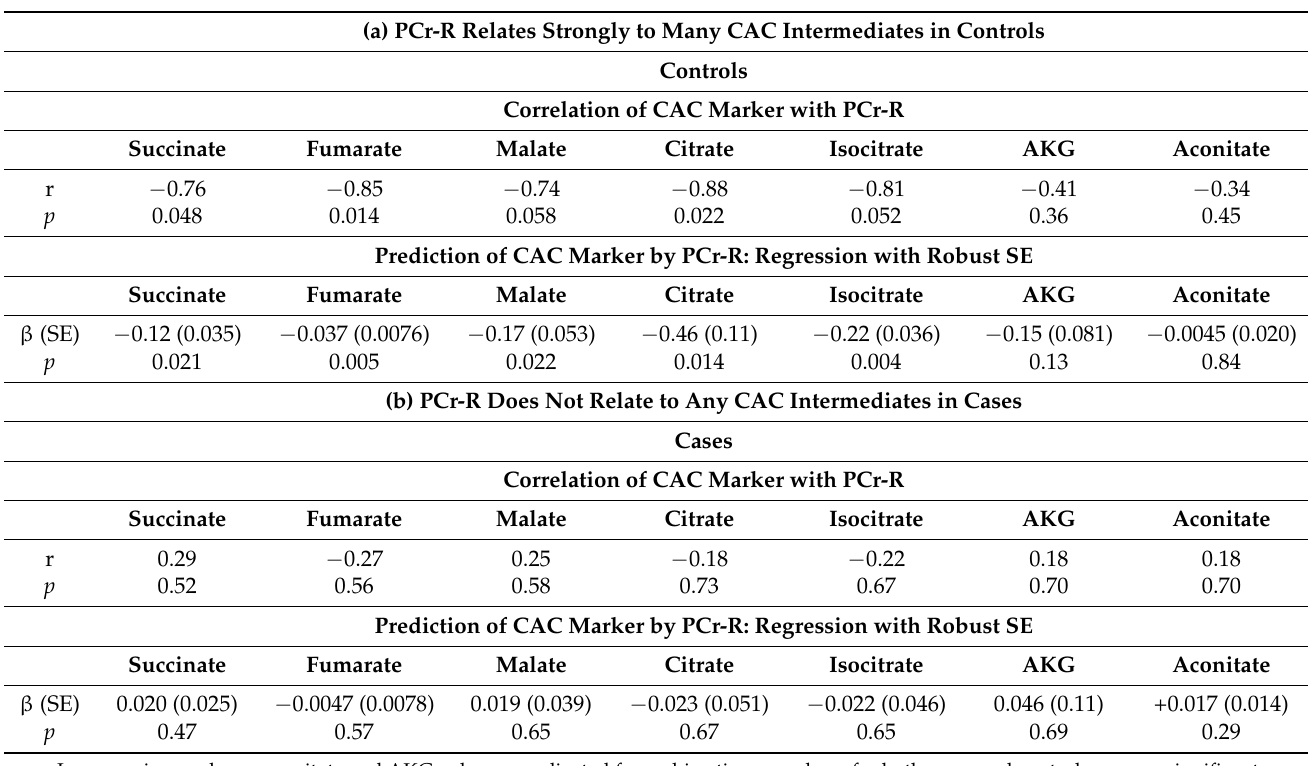
Table 5 and Figure S1a,b show the relationship of CAC markers to PCr-R in controls and GWI cases. In controls, all correlations of CAC markers to PCr-R share a common sign (negative, as might be expected if prolonged PCr-R is indexing a shortfall in energetics of a character that is reflected in lower CAC markers). The typical magnitude of the correlations (absolute value of coefficient) was large: five of these CAC correlations to PCr-R in controls bore a correlation coefficient (absolute value) of 0.74 or greater (all except AKG and aconitate and the lowest absolute magnitude correlation, for aconitate, was 0.34). Correlations of PCr-R to all CAC markers except AKG and aconitate (the two CAC markers influenced by archive time) were significant or borderline significant in controls. Table 5. Relation of PCr-R to CAC markers: Correlation and regression with robust standard errors (a) PCr-R Relates Strongly to Many CAC Intermediates in Controls Controls Correlation of CAC Marker with PCr-R